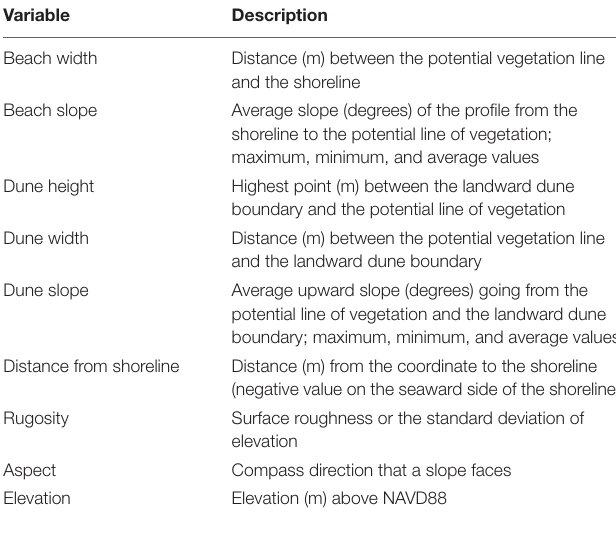
TABLE 1 | Description of each geomorphology characteristic extracted to each presence and pseudo-absence point.